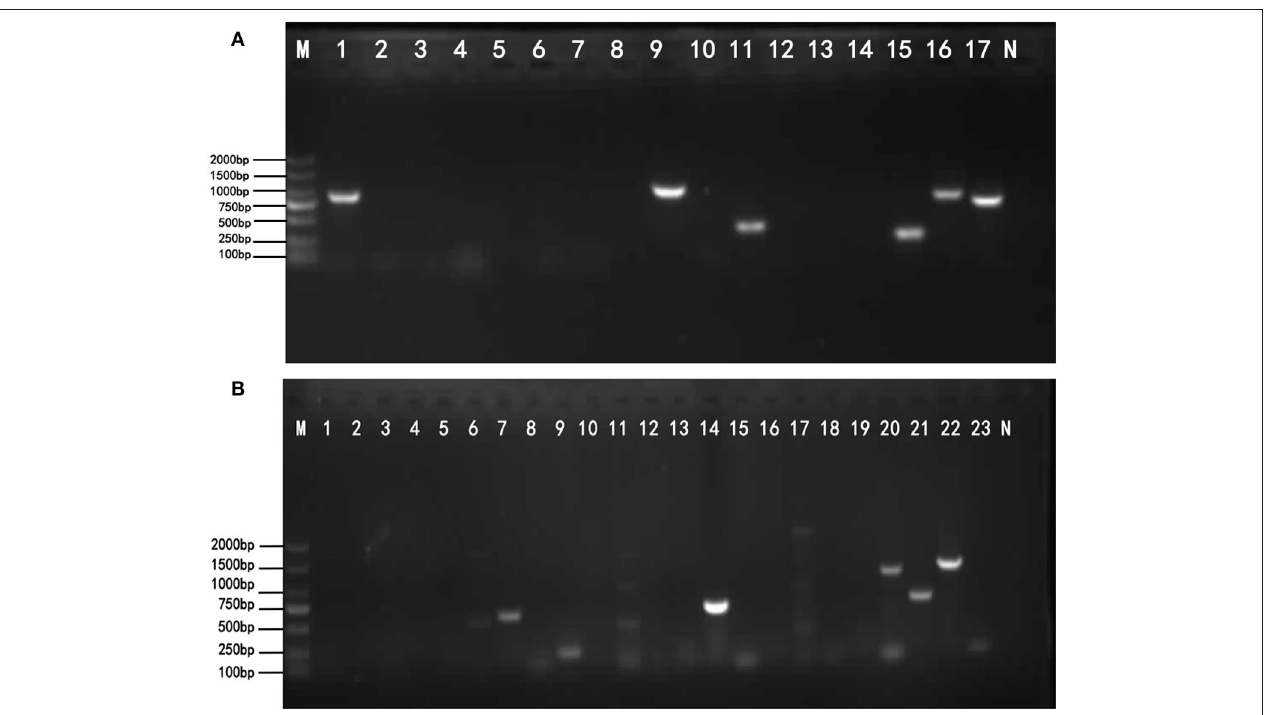
FIGURE 2 | The results of drug-resistant genes and virulence genes. (A) The target resistant genes were amplified by PCR using the primers listed in Table 2 . Lane M: DNA Marker DL2000 (from top to bottom is 2,000–1,500–1,000–750–500–250–100 bp). Lane 1–17: Resistance gene; Lane N: Negative control. The lane 1, lane 9, lane 11, lane 15, lane 16, and lane 17 show bright strips, which are, respectively, 643, 984, 343, 258, 822, and 722 bp. The results of the detected genes are shown in Table 5 . (B) The target virulence genes were amplified by PCR using the primers listed in Table 3 . Lane M: DNA Marker DL2000 (from top to bottom is 2,000–1,500–1,000–750–500–250–100 bp). Lane 1–23: virulence genes; Lane N: Negative control. The lane 7, 8, 9, 14, 20, 21, 22, and 23 show bright strips. The virulence genes corresponding to these positive bands are shown in Table 6